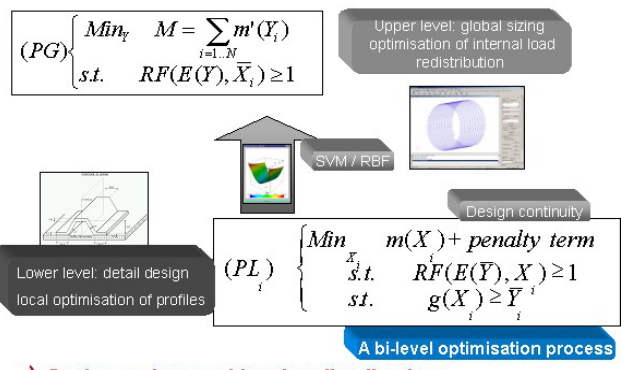
Fig. 24. A candidate solution for a multi-level decomposition